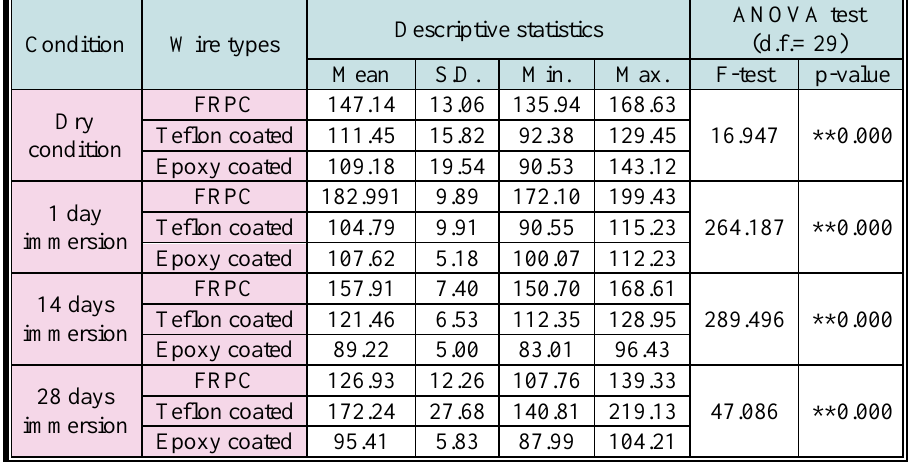
Table 1: Mean and S.D. values of the average roughness (Ra) in nm of different esthetic archwire types.